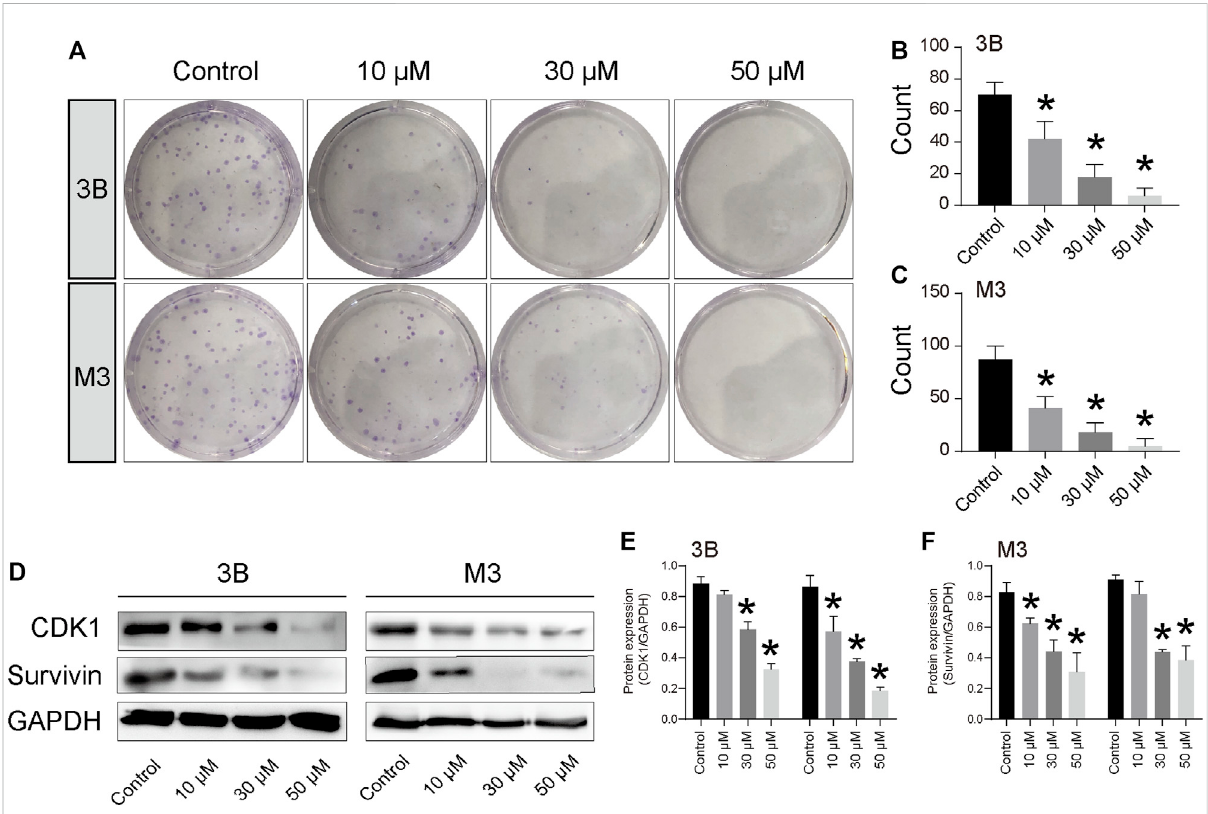
FIGURE 2 STA inhibits Hep3B and HCCLM3 cell proliferation. (A – C) Clone formation of Hep3B and HCCLM3 cells treated with STA at 10 μ M, 30 μ M, and 50 μ M. (D – F) The representative bands of CDK1 and survivin in Hep3B and HCCLM3 cells treated with STA at 10 μ M, 30 μ M, and 50 μ M for 48 h. GAPDH was used as an internal control. Data shown are means ± SD; n = 3. * p < 0.05, signi fi cantly from control